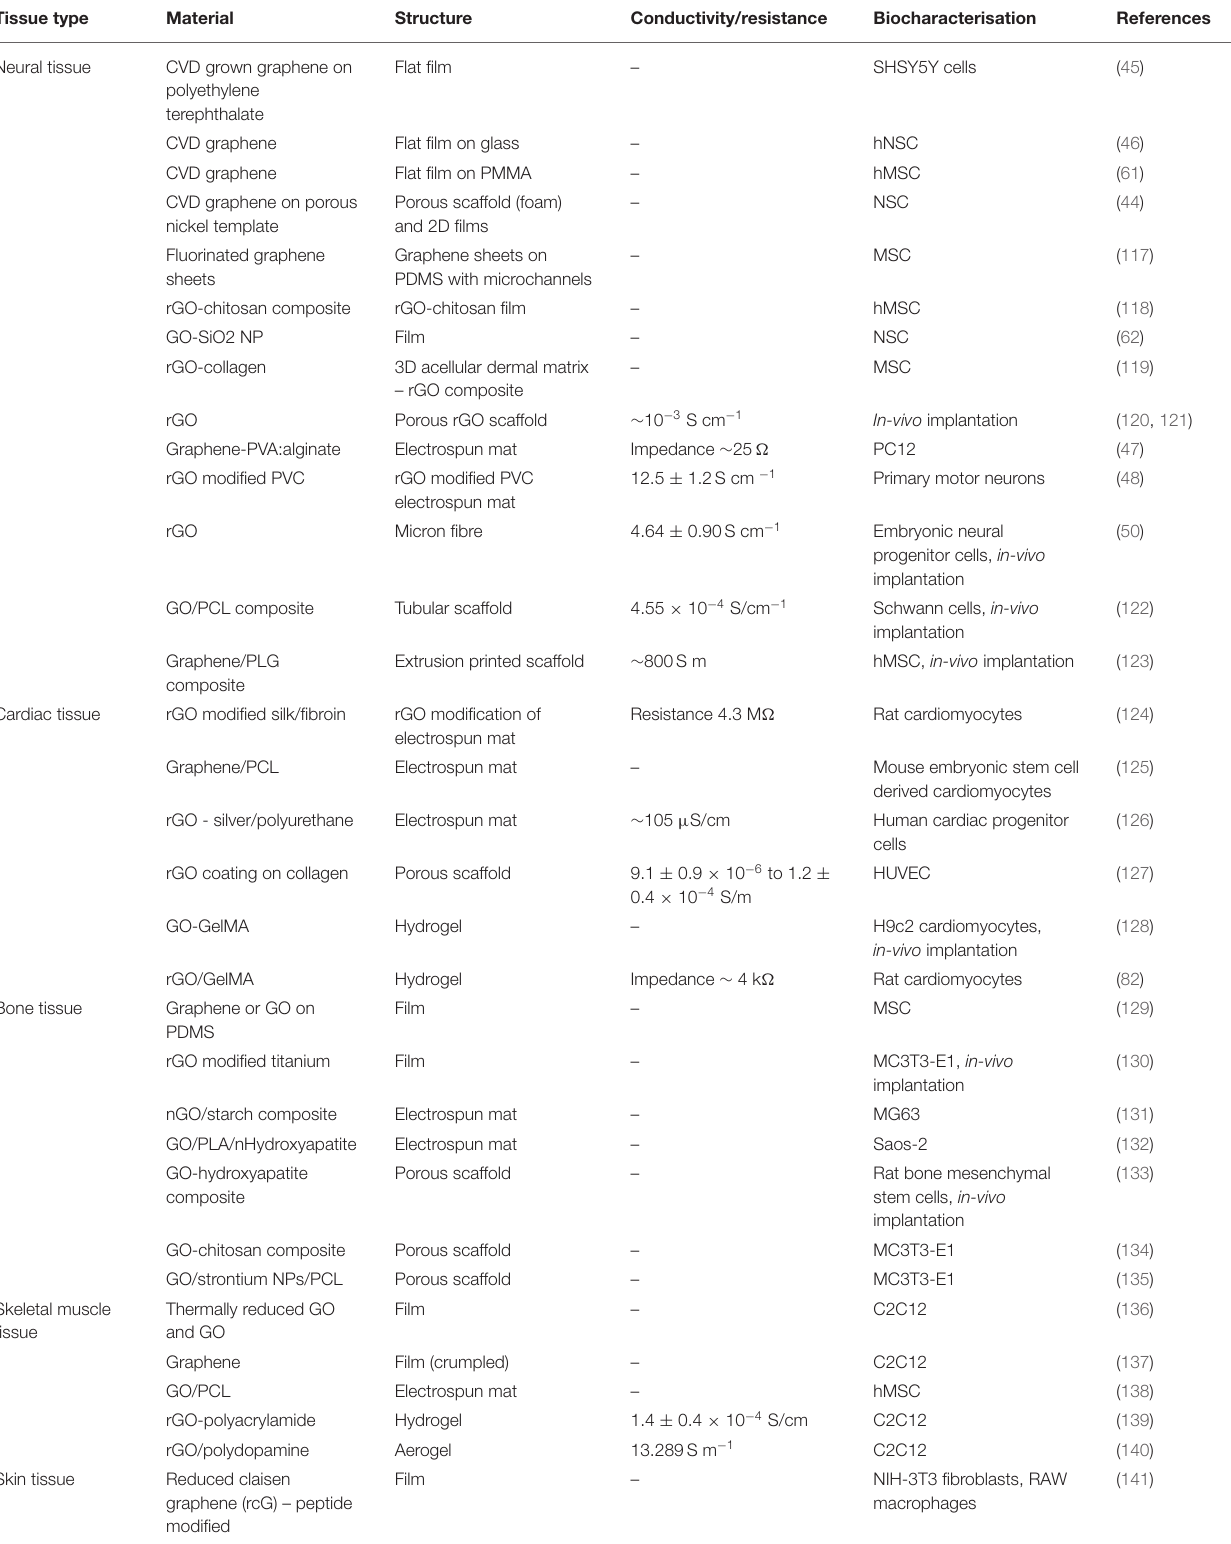
TABLE 3 | Summary of studies describing graphene and graphene oxide biomaterial application for tissue